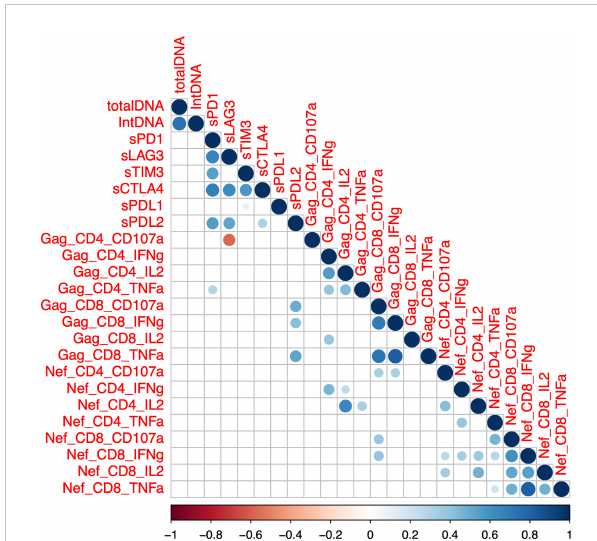
FIGURE 3 Correlation between soluble immune checkpoint proteins, reservoir size and the frequency of Gag or Nef-speci fi c CD4+ and CD8+ T cells. Intracellular cytokine staining was performed using peripheral blood mononuclear cells from participants on antiretroviral therapy (SCOPE (n=48)) and expression of interferon-gamma (IFN-g), tumor necrosis factor-alpha (TNF-a), interleukin-2 (IL-2) and the degranulation marker CD107a was quanti fi ed using fl ow cytometry in both CD4 and CD8 T-cells. Soluble (s) immune checkpoint proteins were quanti fi ed in plasma as previously described. Dots represent statistical signi fi cance of a Spearman correlation with p < 0.05, and colour gradient indicates the coef fi cient and the directionality of the correlation. Programmed Cell Death protein 1 (PD-1), Lymphocyte Activation Gene-3 (LAG-3), T cell Immunoglobulin domain and Mucin domain 3 (TIM-3), Cytotoxic T-Lymphocyte-Associated protein 4 (CTLA-4), PD-1 Ligand 1 (PD-L1) and PD-1 Ligand 2 (PD-L2). Total DNA, total HIV DNA; intDNA, integrated HIV